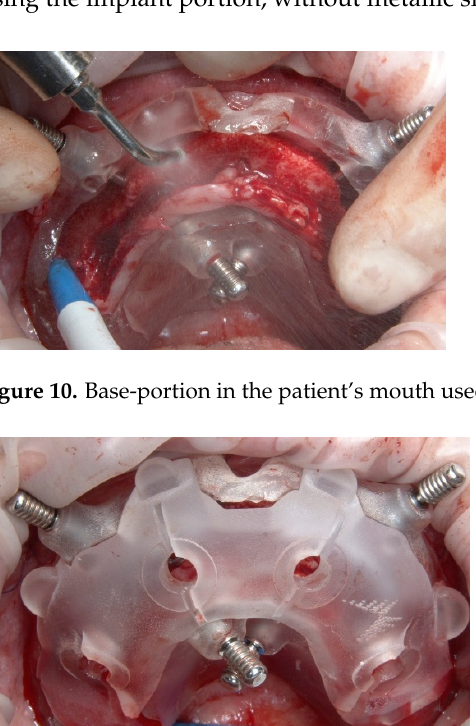
Figure 9. Metal-reinforced temporary restoration.